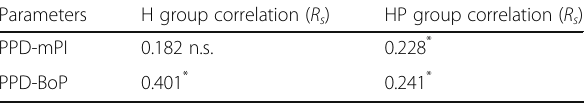
Table 6 Correlations between PPD and the other parameters Parameters H group correlation ( R s ) HP group correlation ( R s )